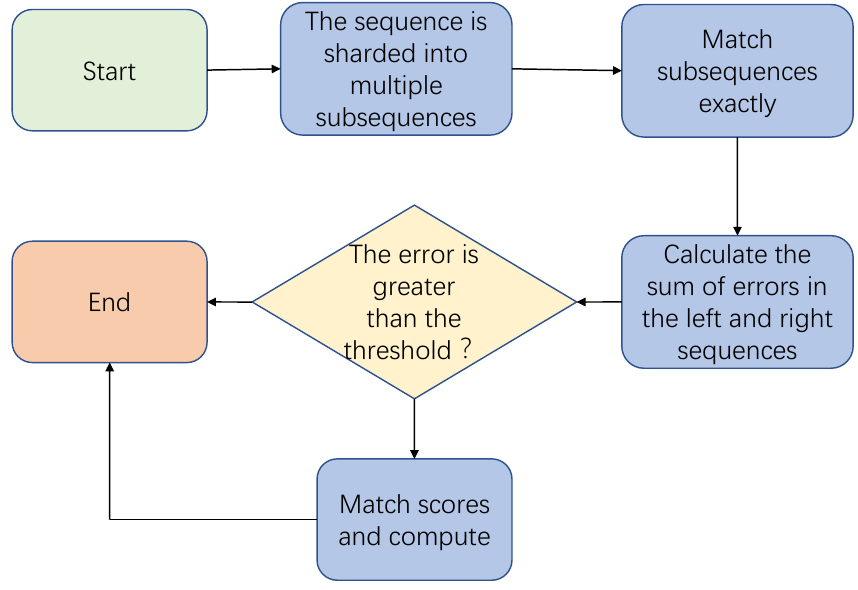
Figure 5. Basic process of fuzzy